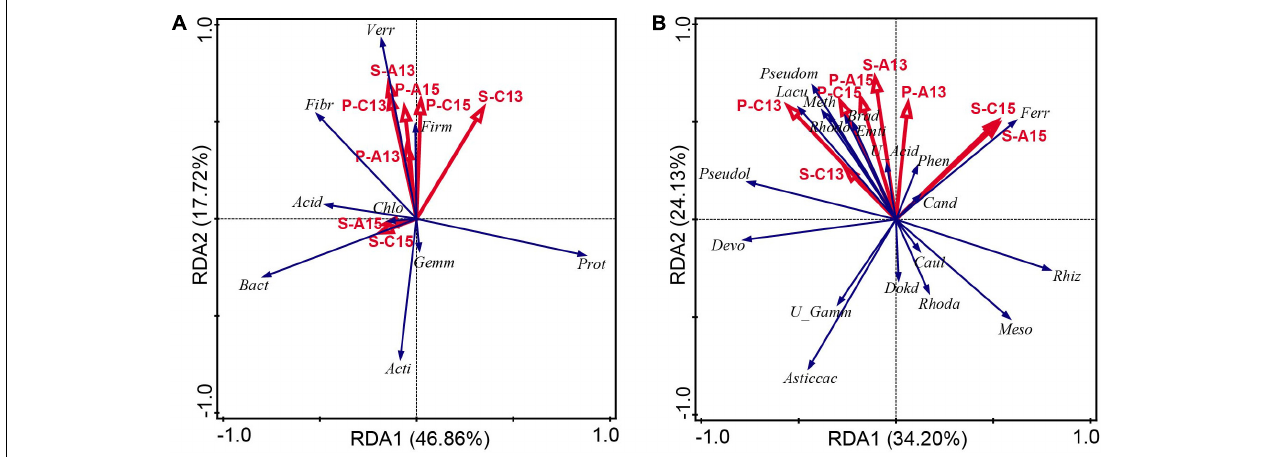
FIGURE 5 | Redundancy analysis of (A) dominant bacterial phyla (relative abundance ≥ 0.5%) and (B) dominant bacterial genera (relative abundance ≥ 0.5%) and significantly different bacterial genera related to metabolism of carbon and nitrogen across all of the soil samples. Phyla and genera are indicated by blue vectors and environmental variables are represented by red vectors. The positions and lengths of the arrows indicate the directions and strengths, respectively, of the effects of variables on bacterial communities. Abbreviations in panel (A) , Acid, Acidobacteria; Acti, Actinobacteria; Bact, Bacteroidetes; Chlo, Chloroflexi; Fib, Fibrobacteres; Firm, Firmicutes; Gemm, Gemmatimonadetes; P-A13, P-Atom 13 C; P-A15, P-Atom 15 N; P-C13, P-Con 13 C; P-C15, P-Con 15 N; Prot, Proteobacteria; S-A13, S-Atom 13 C; S-A15, S-Atom 15 N; S-C13, S-Con 13 C; S-C15, S-Con 15 N; Verr, Verrucomicrobia. Abbreviations in panel (B) , Asti, Asticcacaulis ; Brad, Bradyrhizobium ; Cand, Candidatus_Solibacter ; Caul, Caulobacter ; Devo, Devosia ; Dokd, Dokdonella ; Emti, Emticicia ; Ferr, Ferruginibacter ; Lacu, Lacunisphaera ; Meso, Mesorhizobium ; Meth, Methylibium ; P-A13, P-Atom 13 C; P-A15, P-Atom 15 N; P-C13, P-Con 13 C; P-C15, P-Con 15 N; Pseudol, Pseudolabrys ;